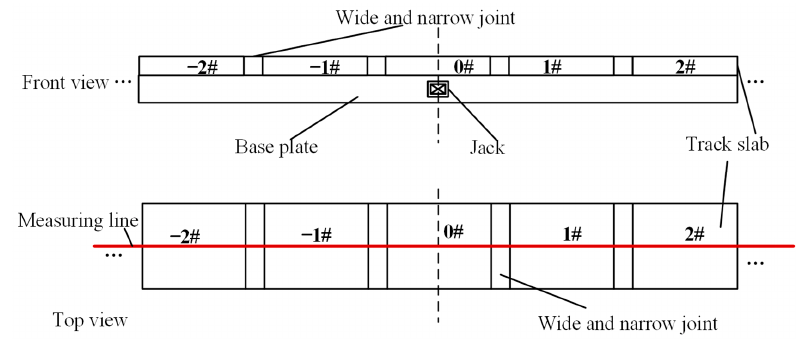
Figure 3. Diagram of single point jacking.